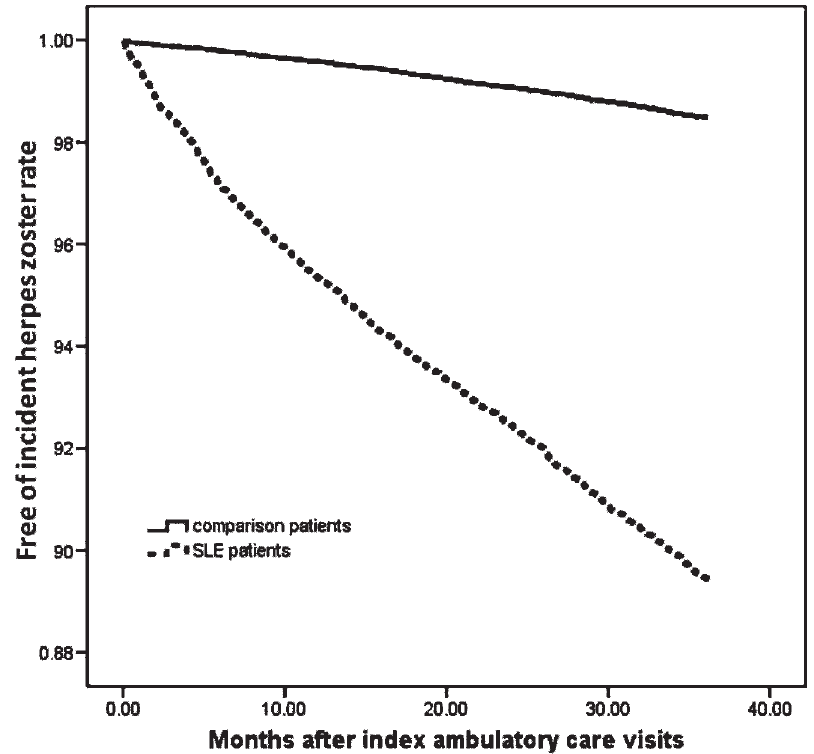
Figure 1 - The survival curves determined using the Kaplan-Meier survival analysis for herpes zoster among SLE patients and non-SLE patients during the three-year follow-up